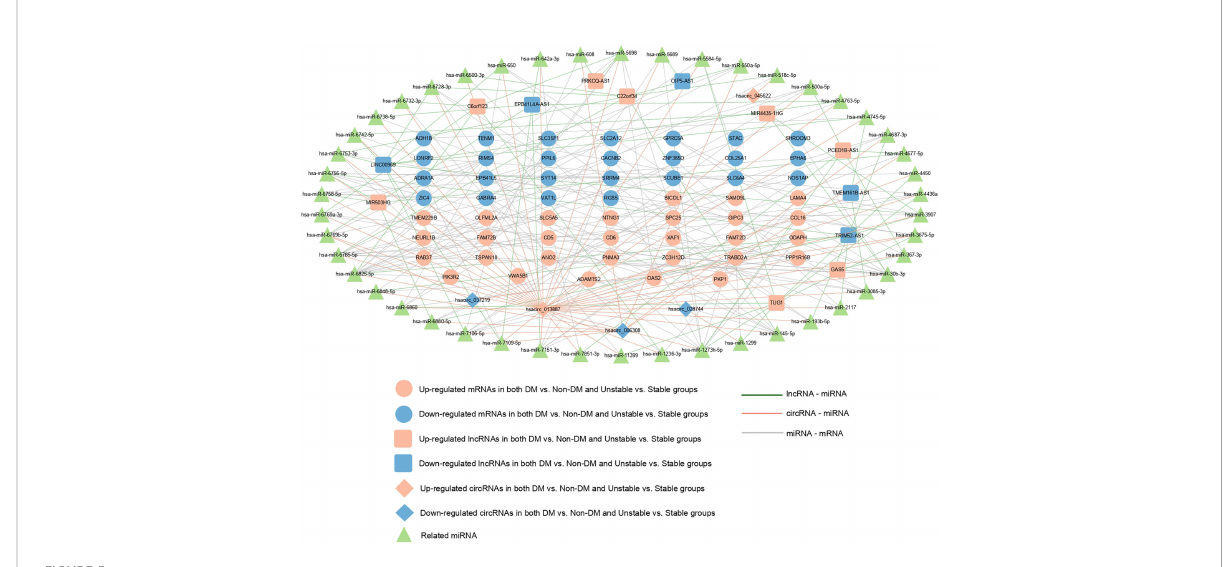
FIGURE 5 ceRNA regulatory network: red and blue represent the RNAs that are signi fi cantly upregulated and downregulated, respectively, in the two comparison groups. Round, diamond, and square respectively represent mRNAs, circRNAs, and lncRNAs, and green triangle represents the related miRNAs. Blue, red, and gray represent lncRNA- miRNA, circRNAs-miRNA, and miRNA-mRNA connections,